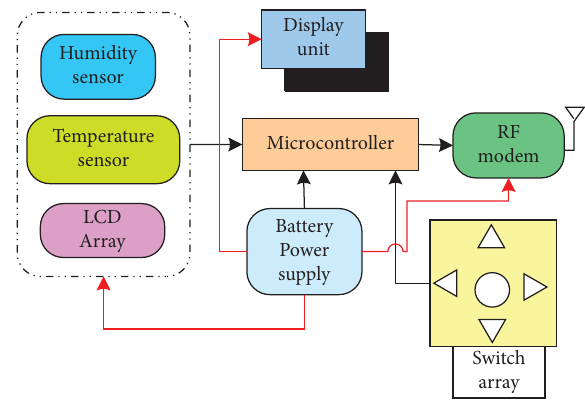
Figure 2: Block diagram of a remote controller section.